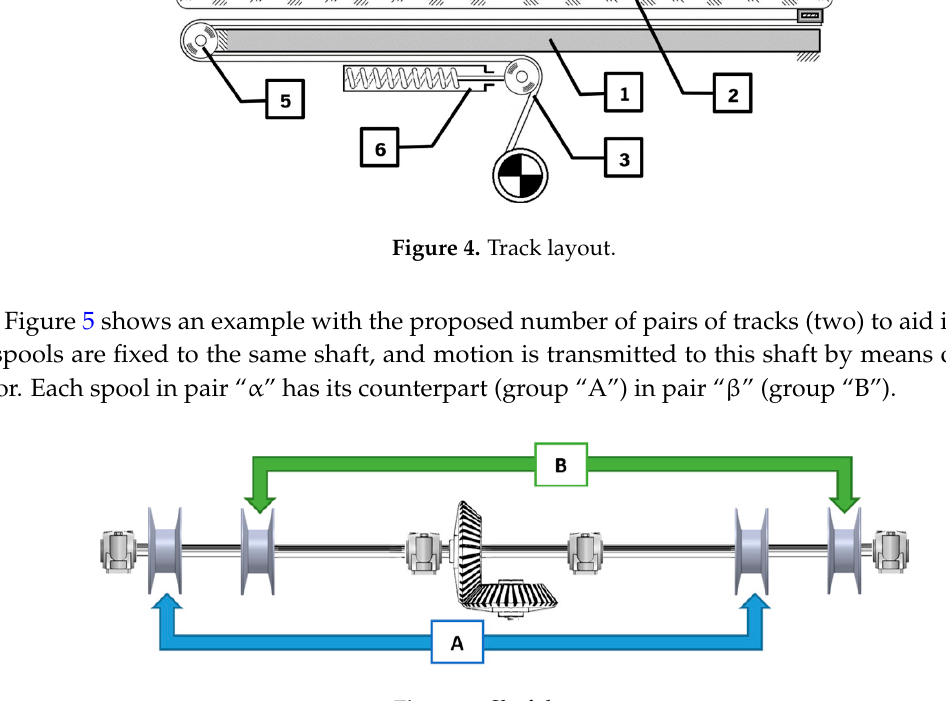
Figure 5. Shaft Figure 5. Shaft layout. Figure 5. Shaft layout.